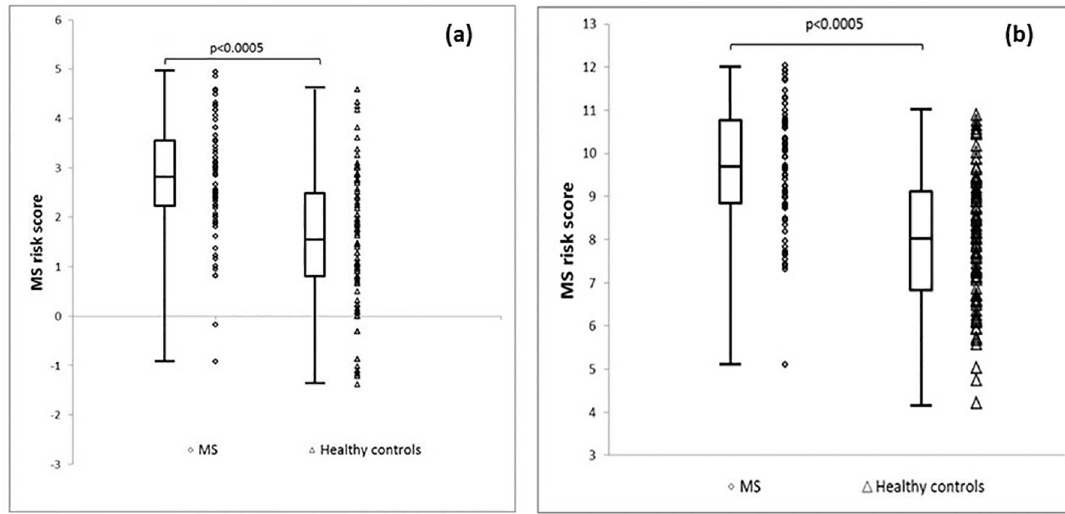
Fig 1. Combined scatter and box-and-whisker plot demonstrating the MS risk score distribution between people with MS and healthy controls. The box indicates the interquartile range, bisected by the median, and the whiskers the range. (a) Where HLA-DRB1 * 1501is the only genetic informationused to derive the risk score. (b) Where full genetic information is used to derive the MS risk